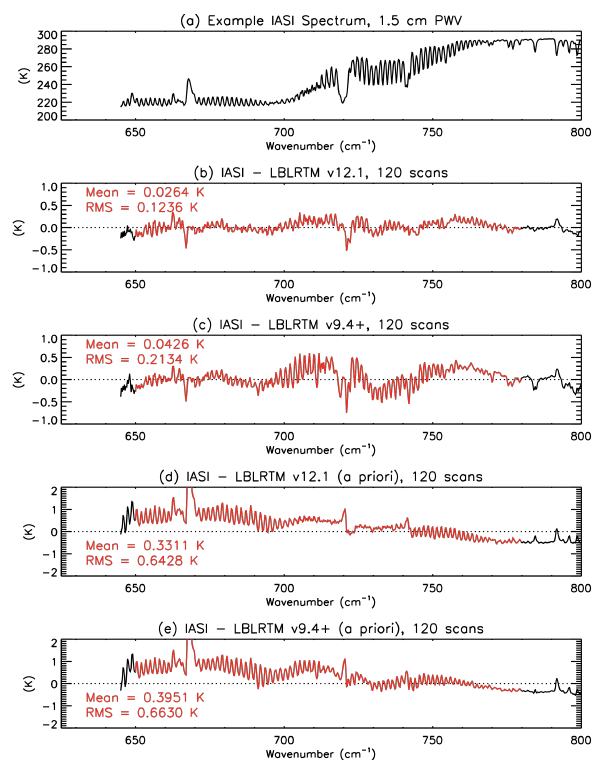
Fig. 3. (a) IASI-observed brightness temperature spectrum in the ν 2 band of CO 2 for an example profile with 1.5cm PWV. (b) Mean of the final (a posteriori) brightness temperature residuals for 120 spectra using LBLRTM v12.1. (c) Mean of the final brightness tem- perature residuals for 120 spectra using LBLRTM v9.4 + . (d) Mean of the a priori brightness temperature residuals for 120 spectra us- ing LBLRTM v12.1. (e) Mean of the a priori brightness temperature residuals for 120 spectra using LBLRTM v9.4 + . A priori residuals in the 667cm − 1 Q-branch peak at approximately 4K. The ν 2 re- trieval window (which was used to retrieve T atm and T srf ) is high- lighted in red. Note that the RMS due to instrument noise alone in this retrieval window is 0.045K.